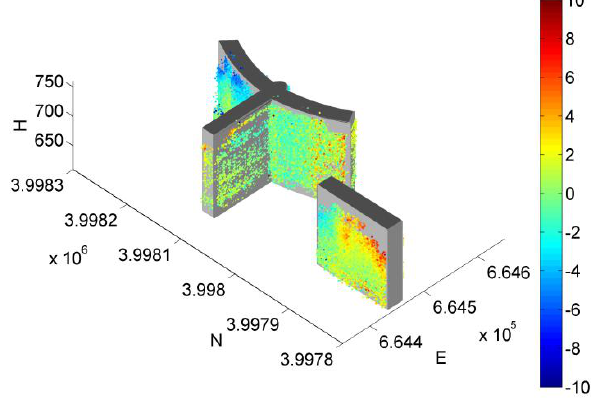
Figure 1: Reconstructed façade model with overplotted TomoSAR points (Zhu, 2013). Colorbar represents the amplitude of seasonal motion (line-of-sight) caused by thermal dilation in millimeters. Axis labels represents 'N' for northing, 'E' for easting in UTM coordinates and 'H' for height in